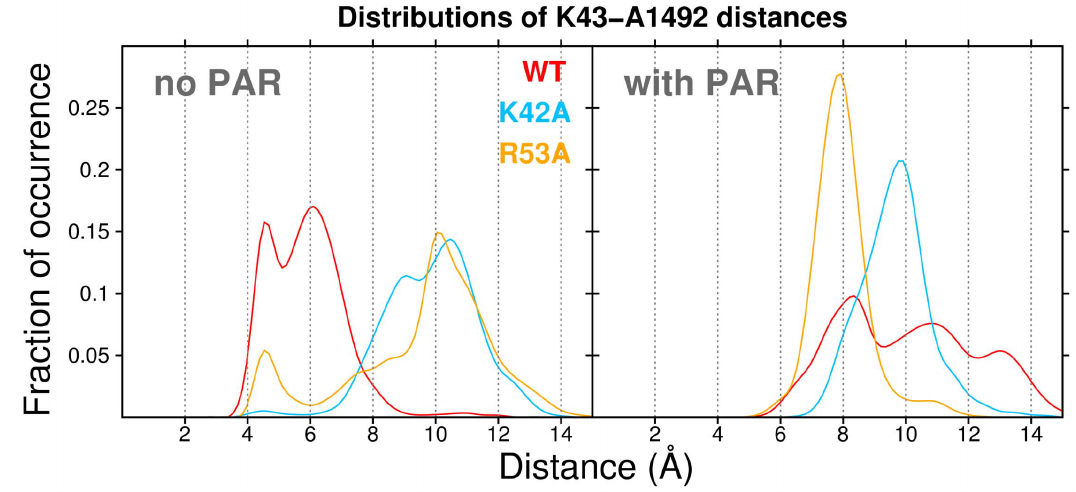
Figure 8. MD-derived distributions of A1492 ??? K43 contacts are plotted as distances (in A˚) between the centers of mass of the A1492 nucleobase and the K43 side-chain in different simulation variants. The data are aggregated from three independent MD